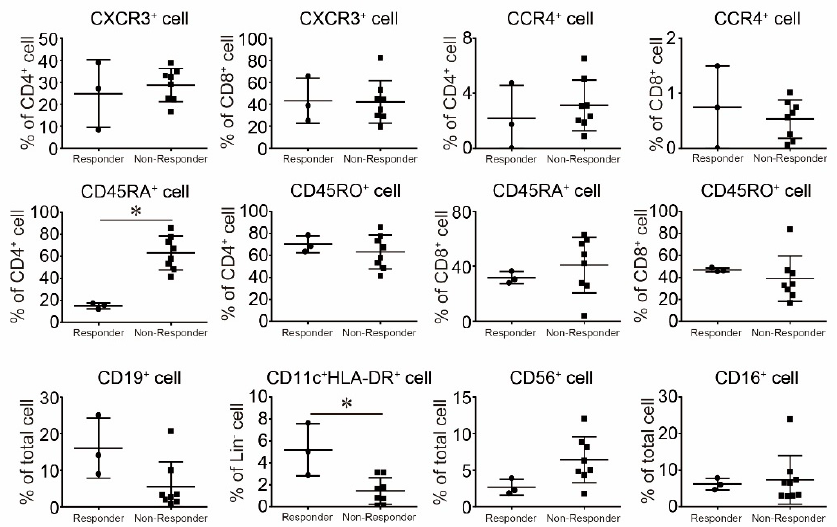
Figure 5. The Comparison of the Frequencies of Immune Cells between Responders and Non- Responders to Nivolumab. The frequencies of each immune cell were evaluated by FACS and we compared the differences in frequency between responders and non-responders to nivolumab. Results are expressed as the mean ± SE. All p -values were obtained by Student’s t test: *, p < 0.05.